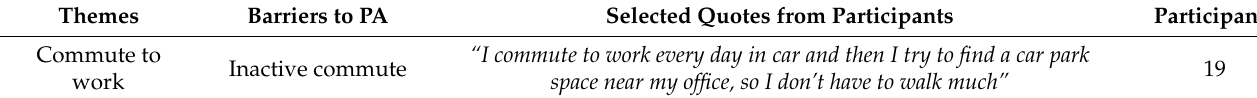
Table 4. A summary of themes and examples of raw data extracts for barriers to and facilitators for PA from inactive group